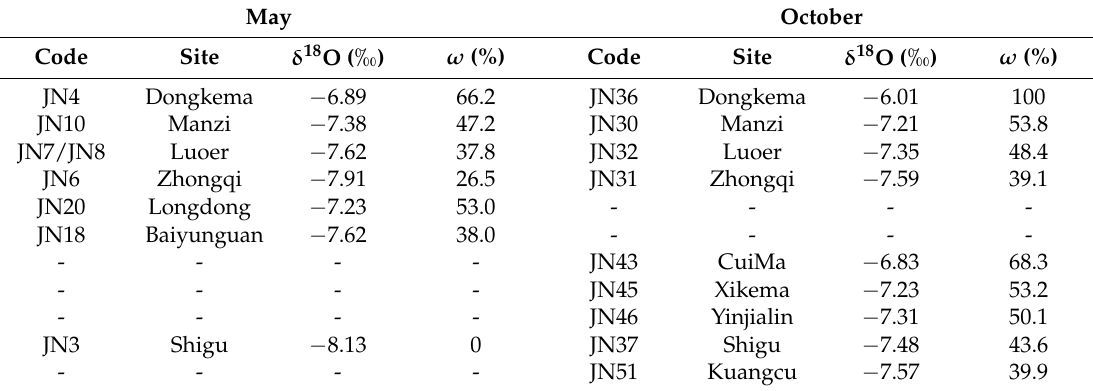
Table 6. The proportion of river water in groundwater samples in May and